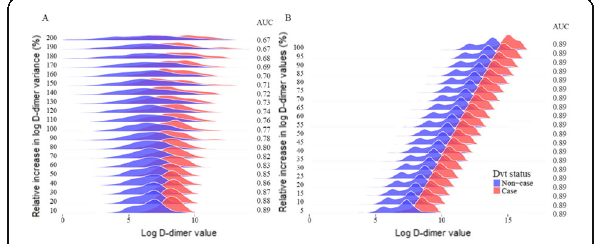
Fig. 1 (abstract O28). See text for